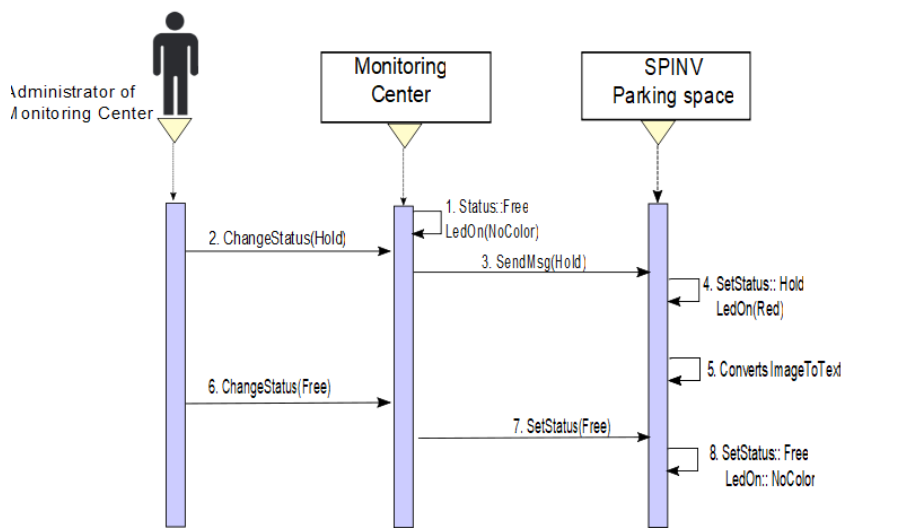
Figure 11. Sequence diagram when an administrator changes the status of one or more spaces to make an adjustment to